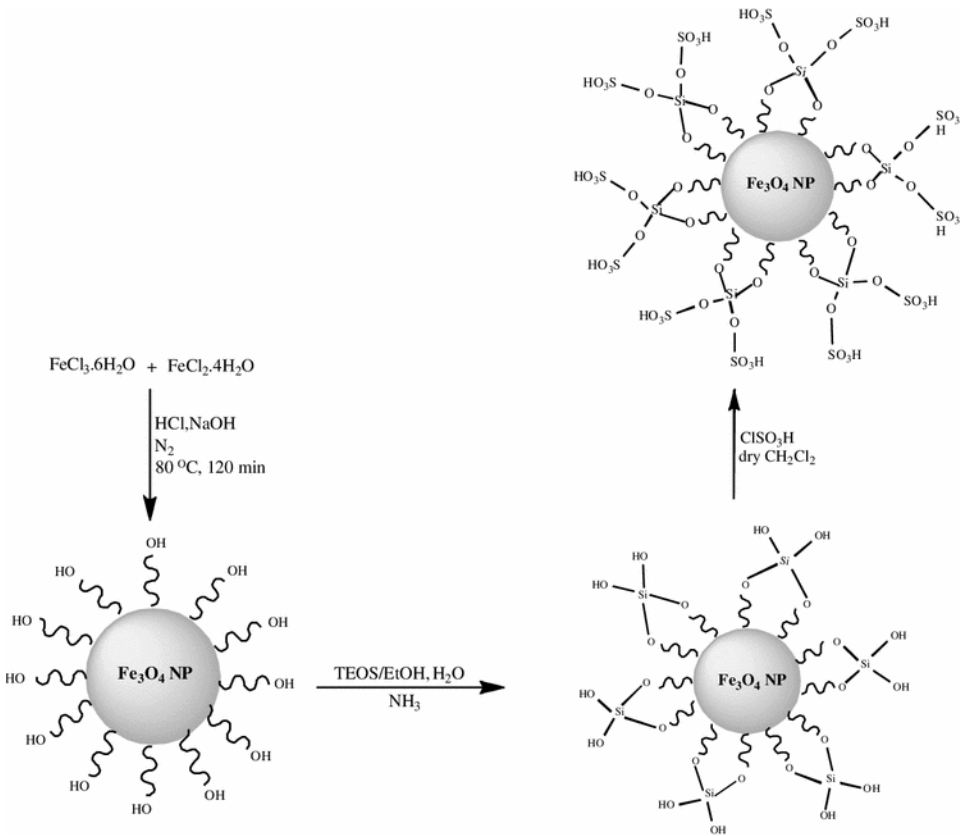
Figure 1. General scheme for the synthesis of silica coating and further acid functionalisation of magnetic Fe Copyright 2013 with permission from